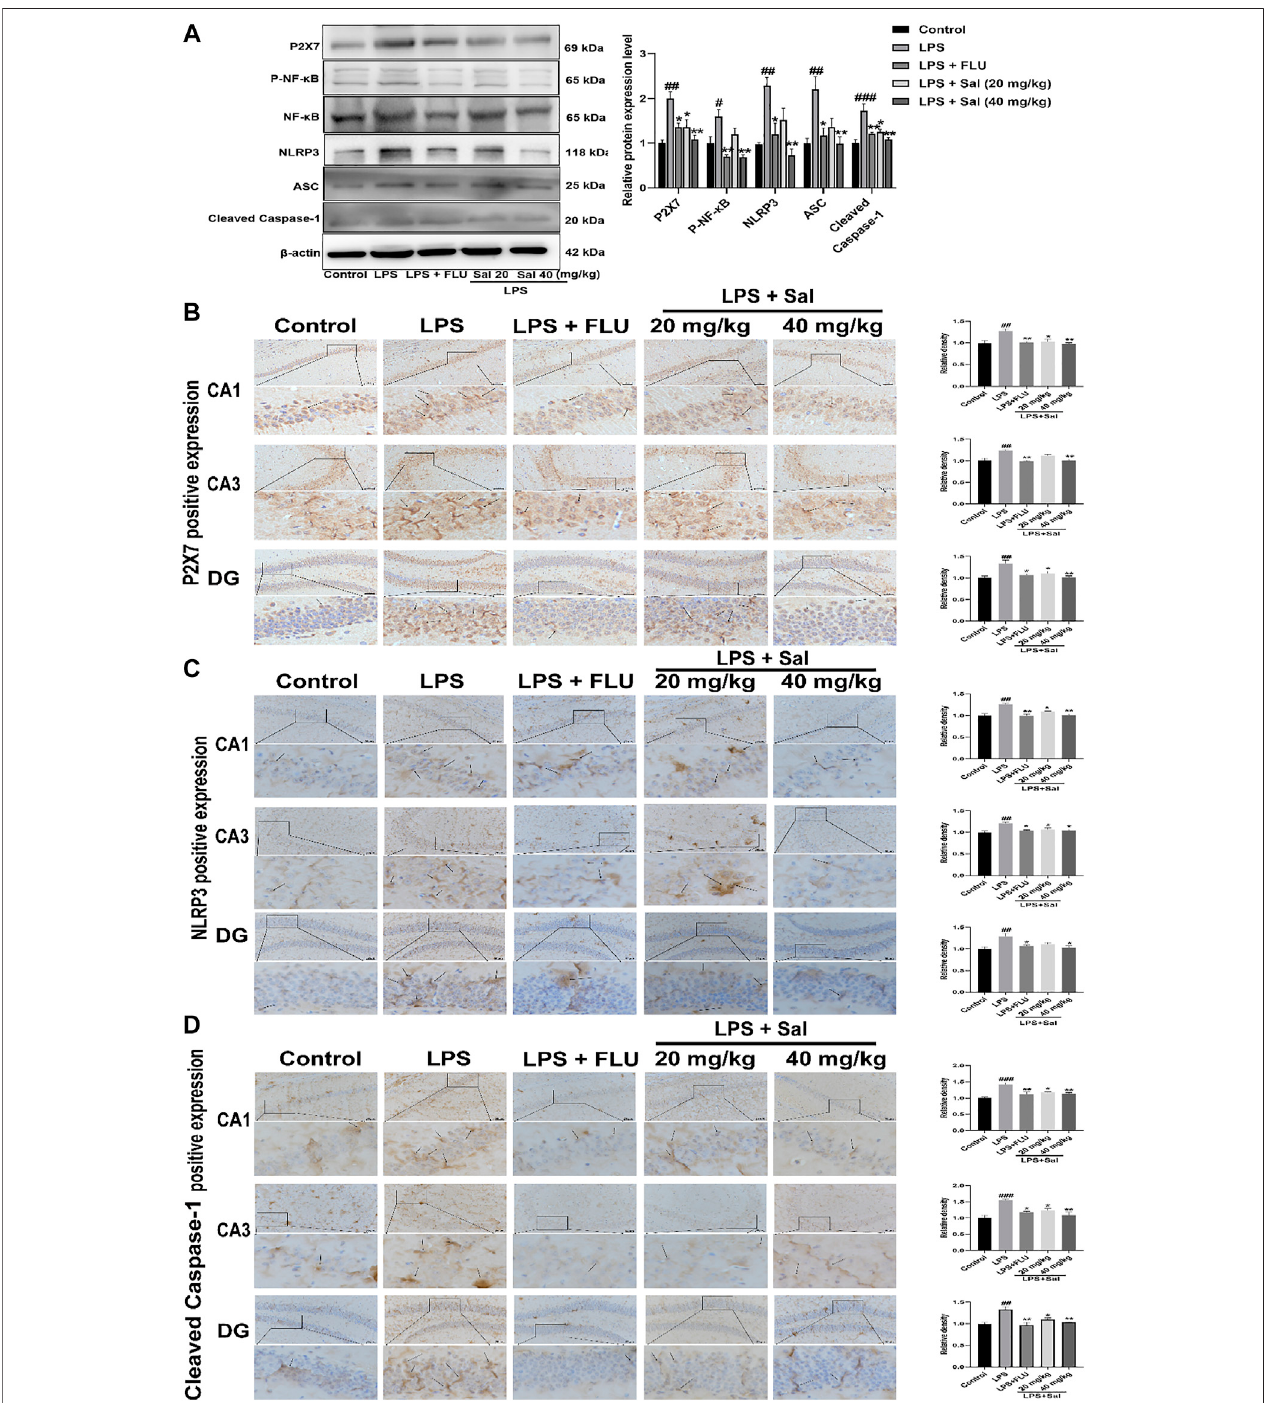
FIGURE 6 | Sal inhibits the P2X7/NF- κ B/NLRP3 signaling pathway in LPS-induced mice. (A) The levels of proteins, including P2X7, P-NF- κ B, NLRP3, ASC, Cleaved caspase-1 in the hippocampus, were determined by Western blot ( n = 3). (B) The levels of P2X7 in the hippocampus were detected by IHC staining. (C) Immunohistochemical staininganalysisofNLRP3 in the hippocampus. (D) Immunohistochemical results ofCleaved caspase-1 in the hippocampus. The typical positive stainingofP2X7,NLRP3 and Cleaved caspase-1were represented bybrownstaining(black arrows). Originalmagni fi cation: ×200, n =3. ### p < 0.001, ## p < 0.01 compared to the control group; ** p < 0.01, * p < 0.05 compared to the LPS group.